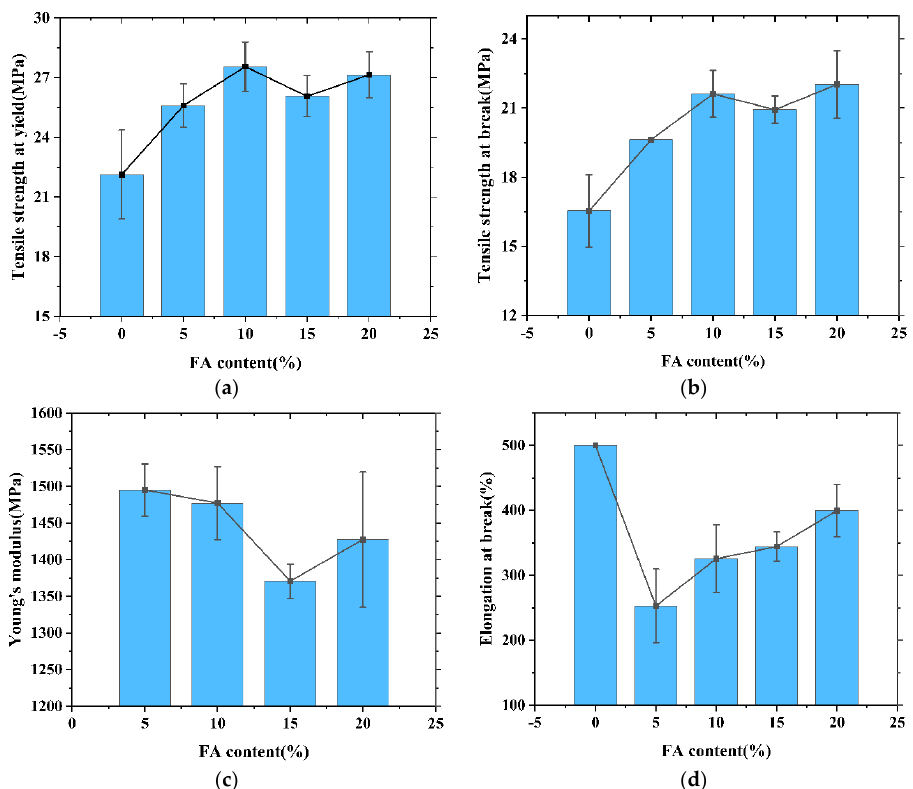
Figure 6. Plot of effect of FA masterbatch on the mechanical properties. ( a ) Tensile strength at yield versus FA masterbatch percentage; ( b ) Tensile strength at break versus FA masterbatch percentage; ( c ) Young’s modulus versus FA masterbatch percentage; ( d ) Elongation at break versus FA masterbatch percentage. Table 3. Effect of FA on tensile properties of composites.